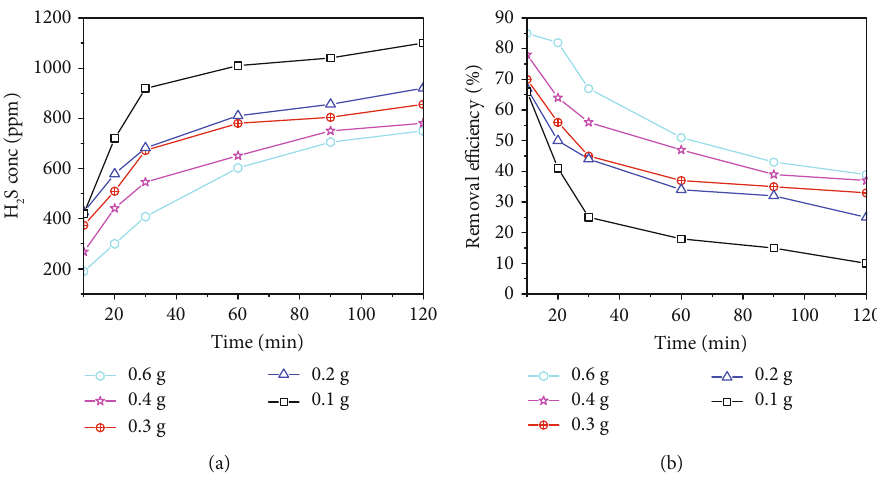
Figure 7: E ff ect of adsorbent mass on the RR adsorption performance: H = 1000 ° C , FR = 0 : 06m 3 /h , particlesize = 0 : 32 ‐ 250 μ m , and C conditions: T c